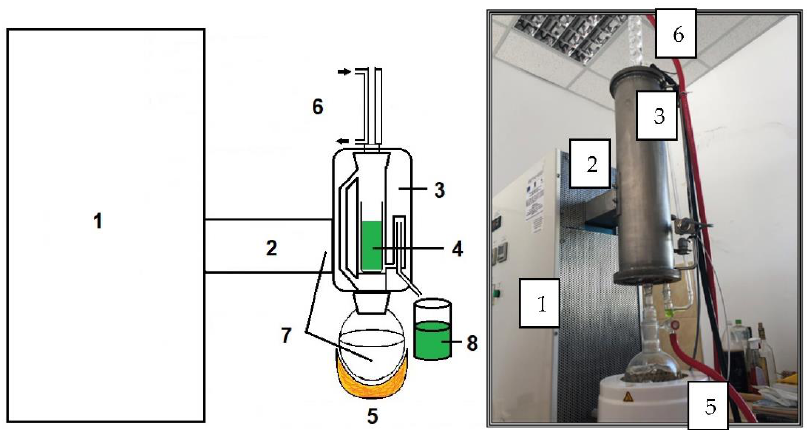
Figure 2. The experimental equipment for the extraction of bioactive compounds from peppermint.